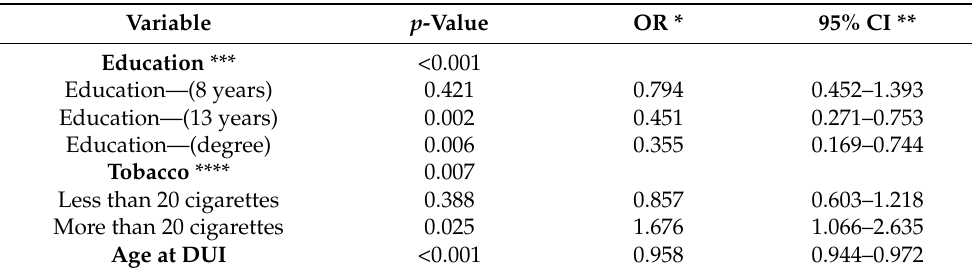
Table 4. p -Value, Odds ratio, and Confidence interval of the variables associated to recidivism using the multiple logistic regression